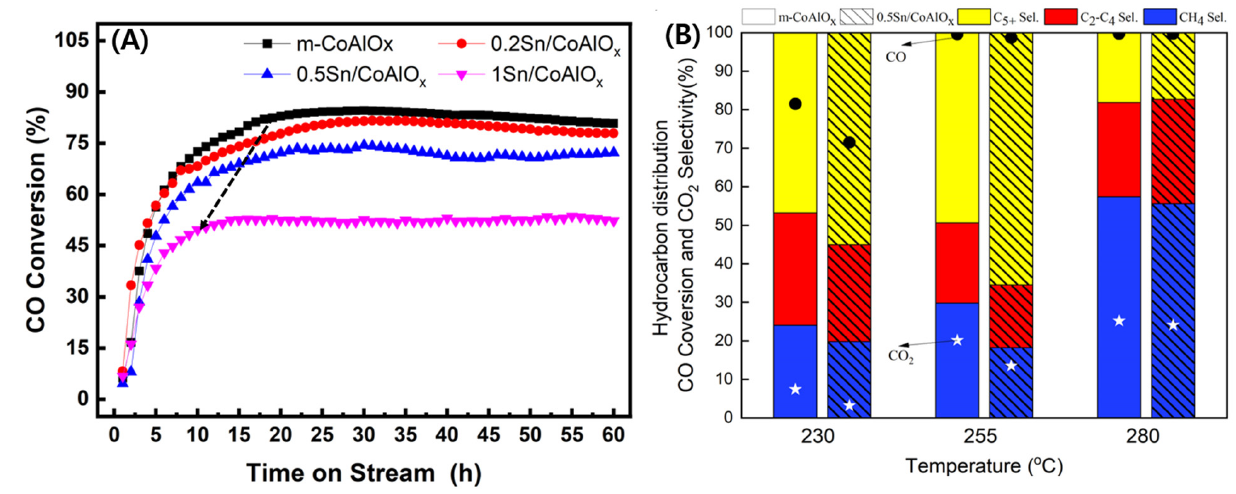
Figure 3. ( A ) CO conversion on the Sn/m-CoAlOx catalysts and ( B ) Temperature effects to product distribution on the pristine m-CoAlOx (undashed histogram) and Sn(7)/m-CoAlOx (dashed histogram).